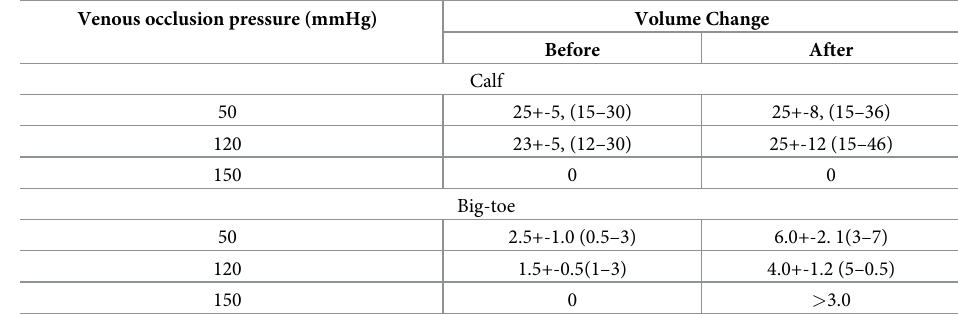
Table 1. Plethysmography of calf and big-toe volume changes before and after 2 years of daily arterial pneumatic support (in